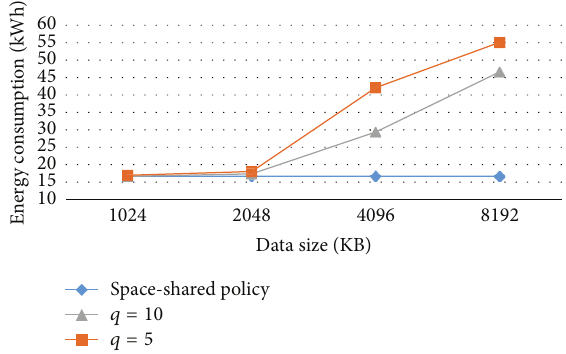
Figure 9: Energy consumption and data size with various quantum